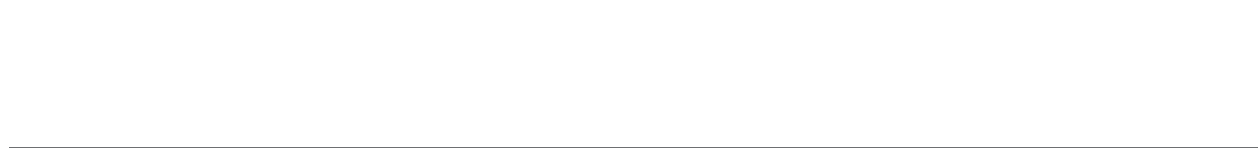
Frontiers in Pharmacology |